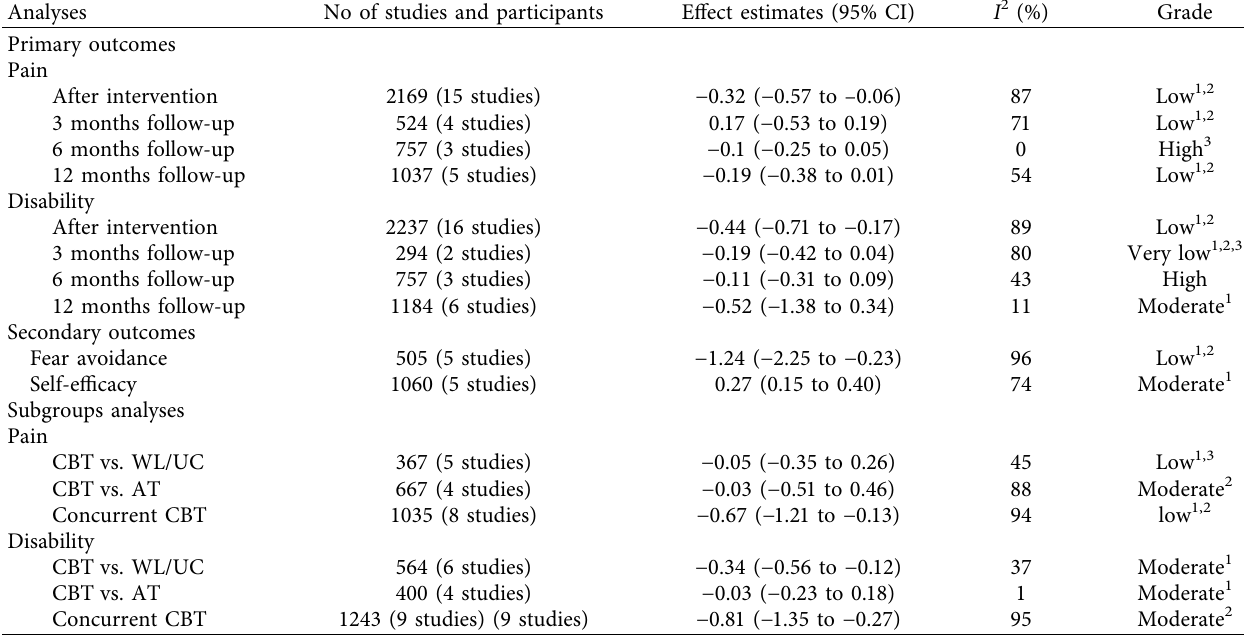
Table 3: Grade of evidence and effect